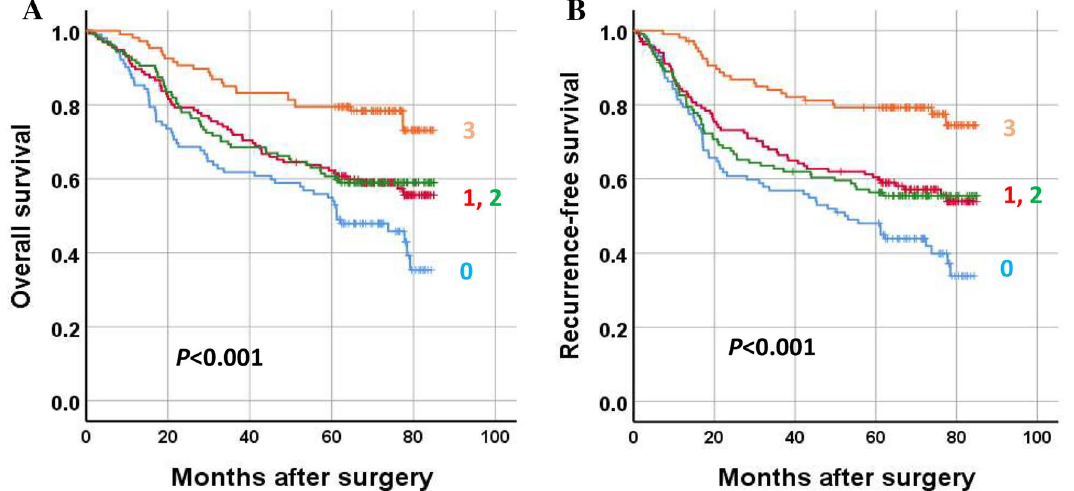
Figure 6. Survival of gastric cancer patients according to the sum score of three DNA methylation markers ( NCOR2 , PARK2 , ZSCAN12 ). ( A ) Overall survival and ( B ) recurrence-free